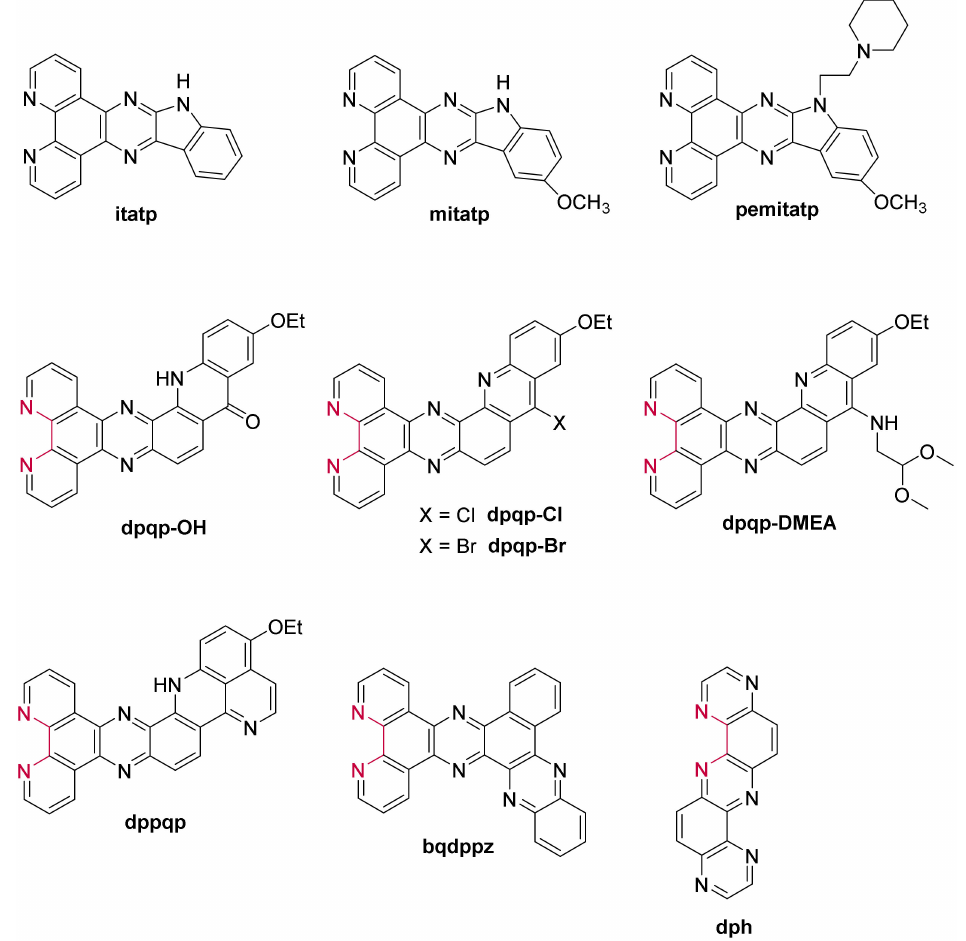
Figure 19. Structure of the π -extended non-symmetrical ligands to form ruthenium(II) complexes studied in presence of